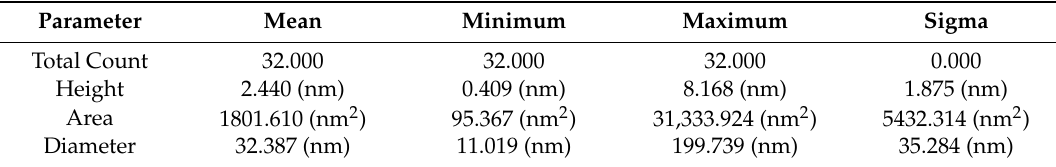
Table 1. Atomic force microscopic statistics of